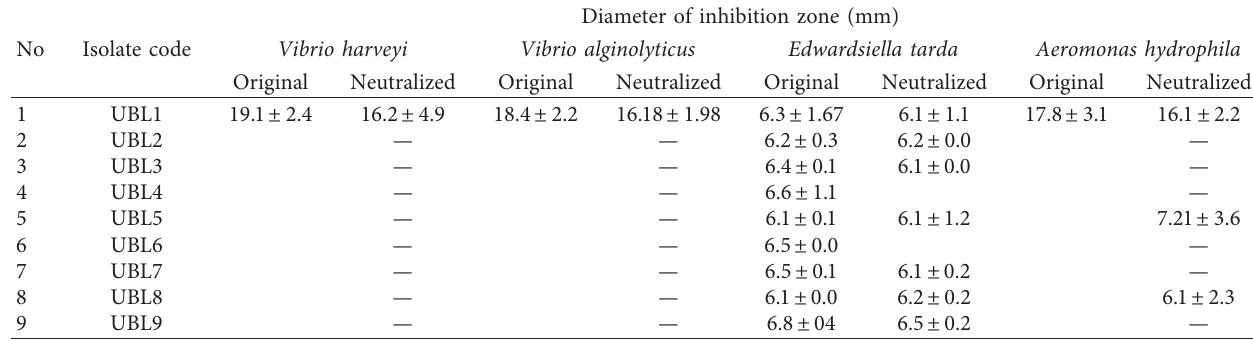
Table 2: Antibacterial activity of isolated bacteria from catfish ( Clarias